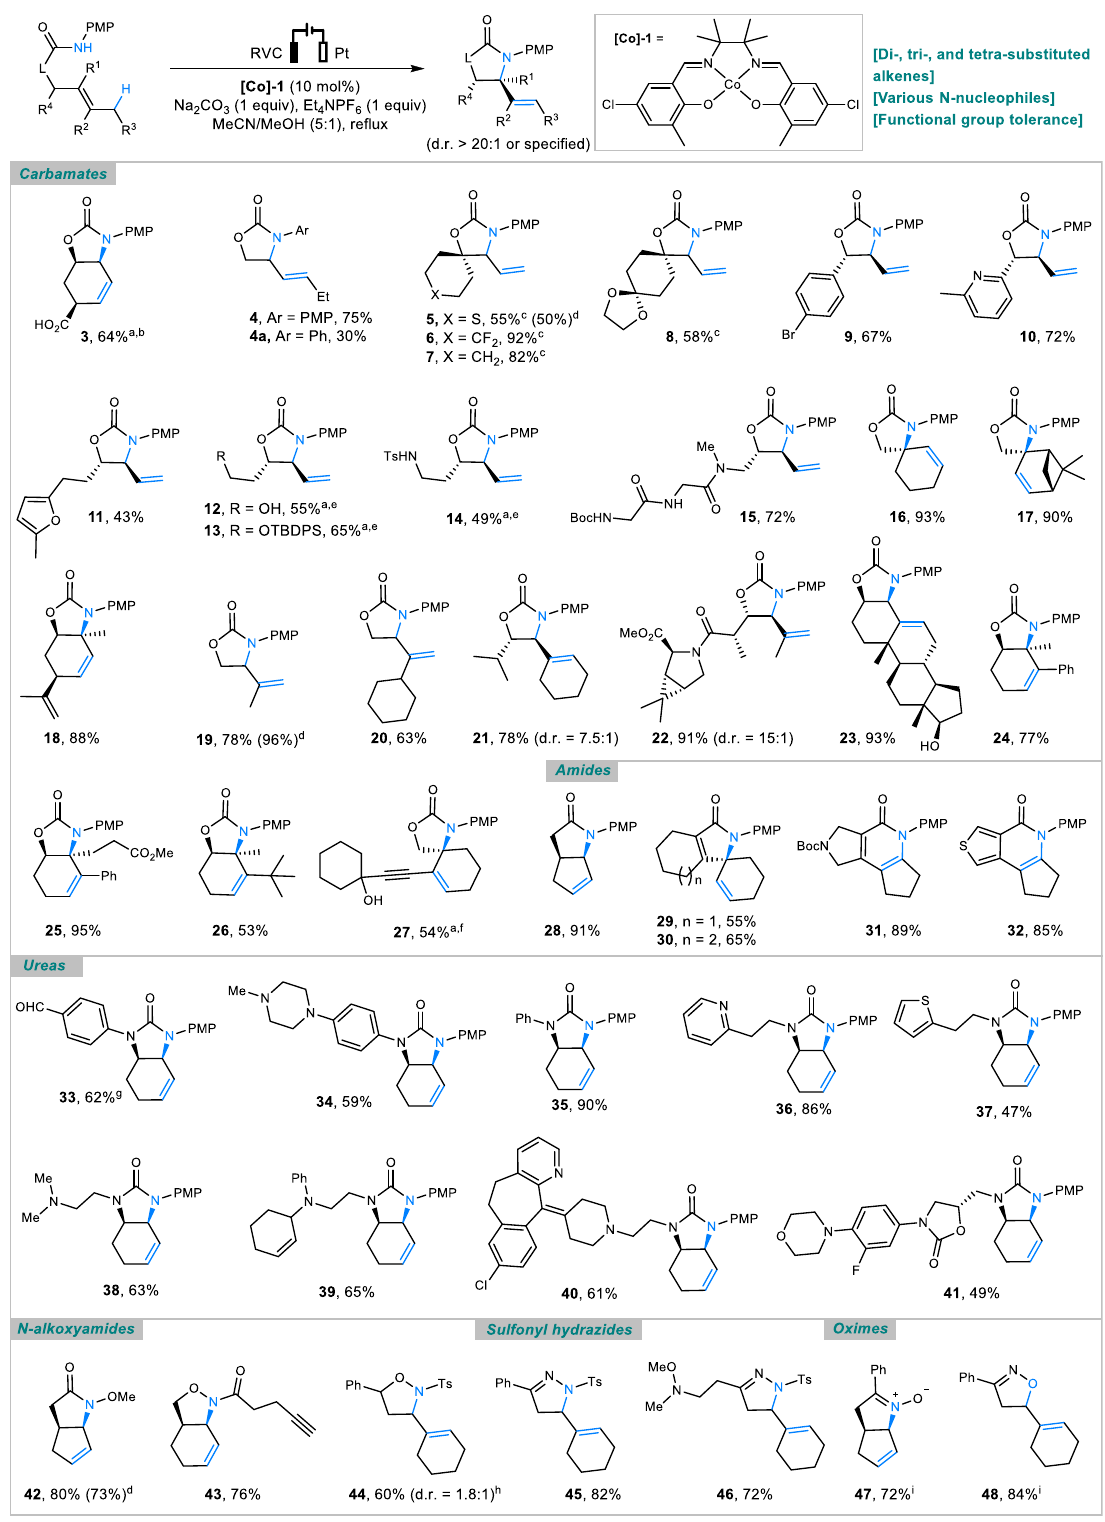
Fig. 2 Scope of allylic C – H amination. Reaction conditions: substrate (0.2 mmol), MeCN (5 mL), MeOH (1 mL), 1.5 – 7.0 h (2.8 – 13.0 F mol − 1 ). All yields are isolated yields. a Reaction with 15 mol% of [Co]-1 . b Reaction with 1.5 equiv. of Na 2 CO 3 . c Current = 8 mA. d Reaction with 0.1 equiv. of Et 4 NPF 6 . e Current = 7 mA. f Current = 6 mA. g Reaction at 60 °C. h Reaction at rt. i K 2 CO 3 as base instead of Na 2 CO 3 . d.r. diastereomeric ratio, Ts tosyl, Boc tert -butyloxy